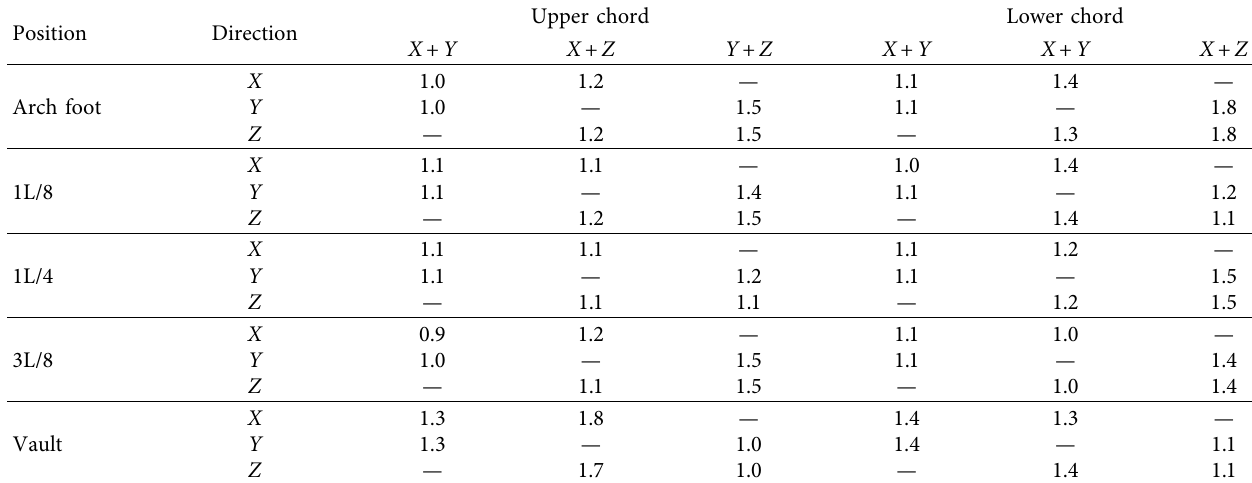
Table 4: Chord axial force ratio table of three dimensions to two